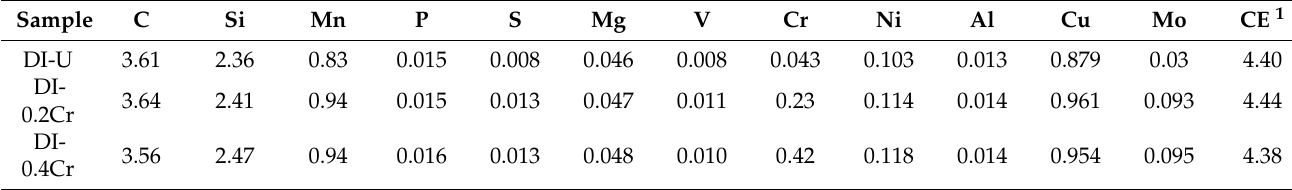
Table 1. Chemical composition for unalloyed and alloyed camshafts with 0.2 and 0.4 wt% Cr.